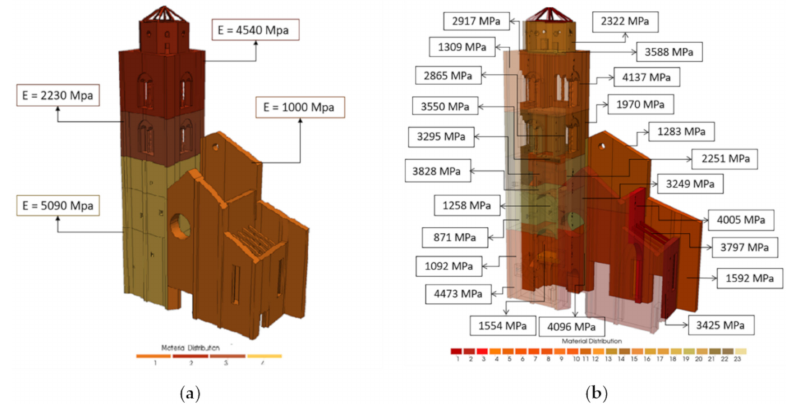
Figure 13. Assigned values of the Young’s Modulus produced by automatic calibration for the NM of step 1 ( a ) of step 2 ( b ).